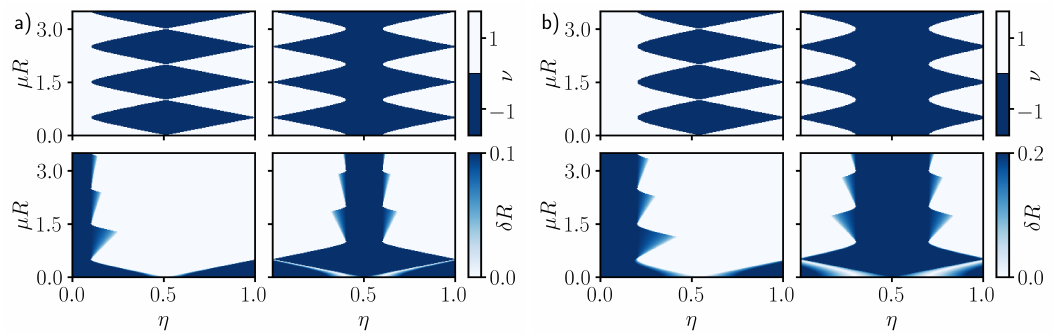
Figure 3: (a) Topological invariant (upper subpanels) and gap estimate δ R (lower subpanels) obtained from the continuum model, with a vortex absent (left subpanels) or present (right subpanels). The pairing potential is ∆ R = a) but with ∆ 0